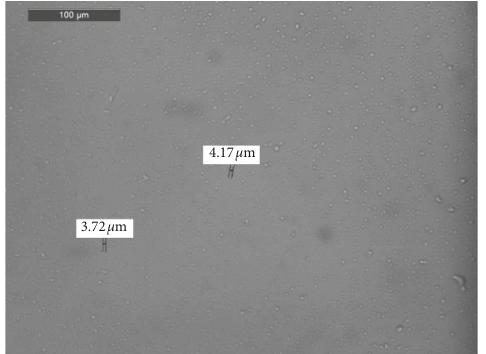
Figure 12: Particles of CMS/CS at ratio 9 (particle size around 4 µ m).